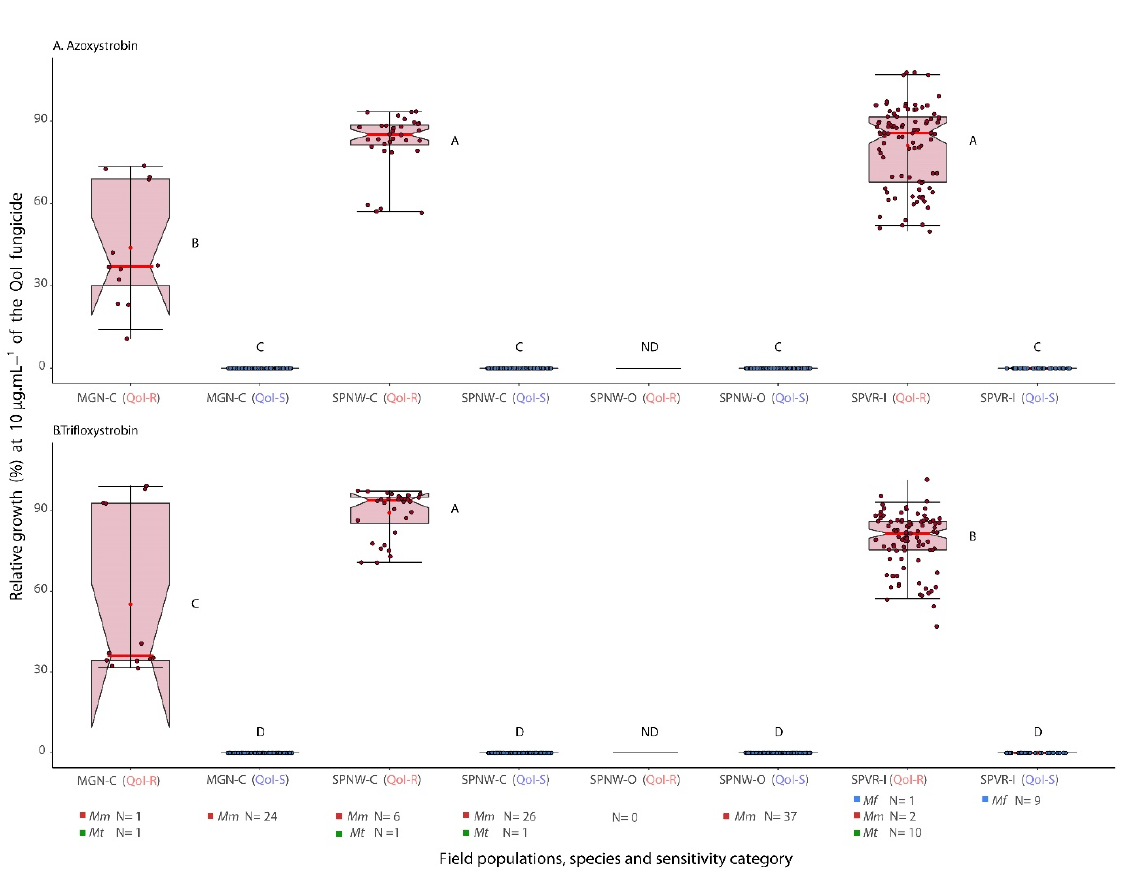
Figure 4. Contrast between groups of QoI resistant (QoI ‐ R) and QoI sensitive (QoI ‐ S) isolates of Mycosphaerella species per geographical population of the pathogen, according to the relative growth at 10 μ g ꞏ mL − 1 of azoxystrobin or trifloxystrobin a,b,c . a The figure depicts boxplots with the medians represented by red lines across the notches, the average as red circles along the whisker lines, and the jittered data points in dark red or dark blue dots to avoid data overplotting. b N = number of QoI ‐ R or QoI ‐ S isolates of Mf (blue square in the x axys), Mm (red square) and Mt (green square) detected per population. c F test from ANOVA significant at p ≤ 0.001. Means followed by the same capital letter are not significantly different by the Scott ‐ Knott test at p ≤ 0.05. N.D. = non ‐ detected.